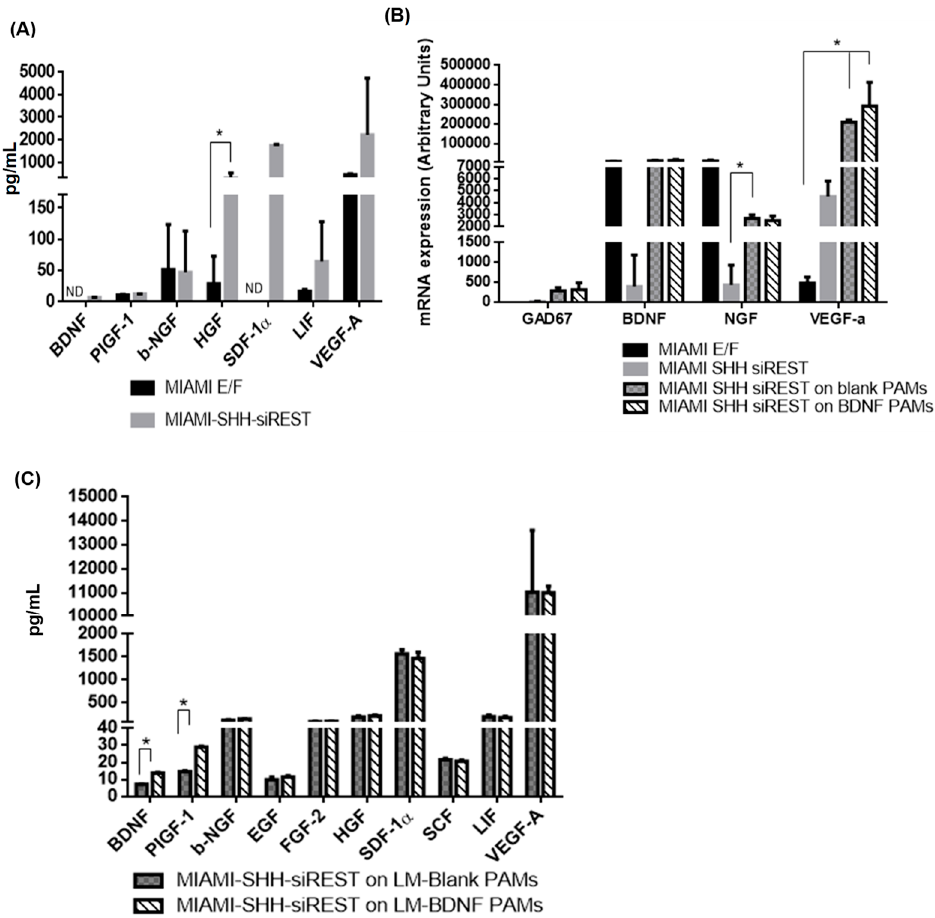
Figure 6. Characterization of the secretome profile of the GABA-like progenitors combined with PAMs. ( A ) Media collected from MIAMI E/F cells or MIAMI-SHH-SiREST cells were analyzed by the Luminex apparatus for the quantification of growth factors and cytokines ( N = 2, n = 2). ( B ) The expression of GABAergic genes and GAD67 and growth factors (BDNF, NGF and VEGFa) was quantified by RT-qPCR 72H after adherence to the PAMs ( N = 3). ( C ) Media collected 72 h after adherence between cells and PAMs were analyzed by the Luminex apparatus for the quantification of growth factors and cytokines ( N = 2, n = 2) N represents one independent experiment with all the conditions, n the number of samples/condition. * Significantly different means at P < 0.05.